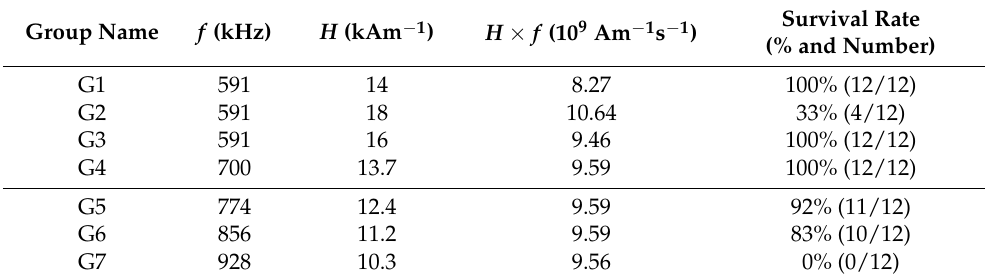
Table 1. Applied electromagnetic fields according to the experimental group and survival rate of each of